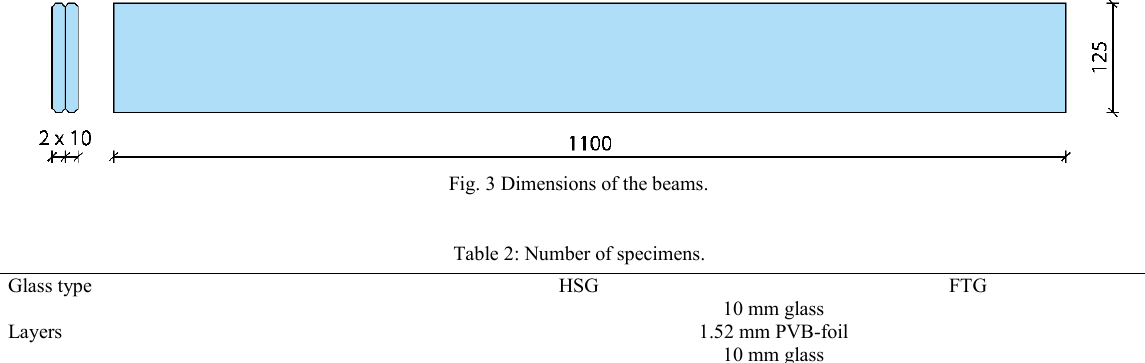
Table 2: Number of specimens.